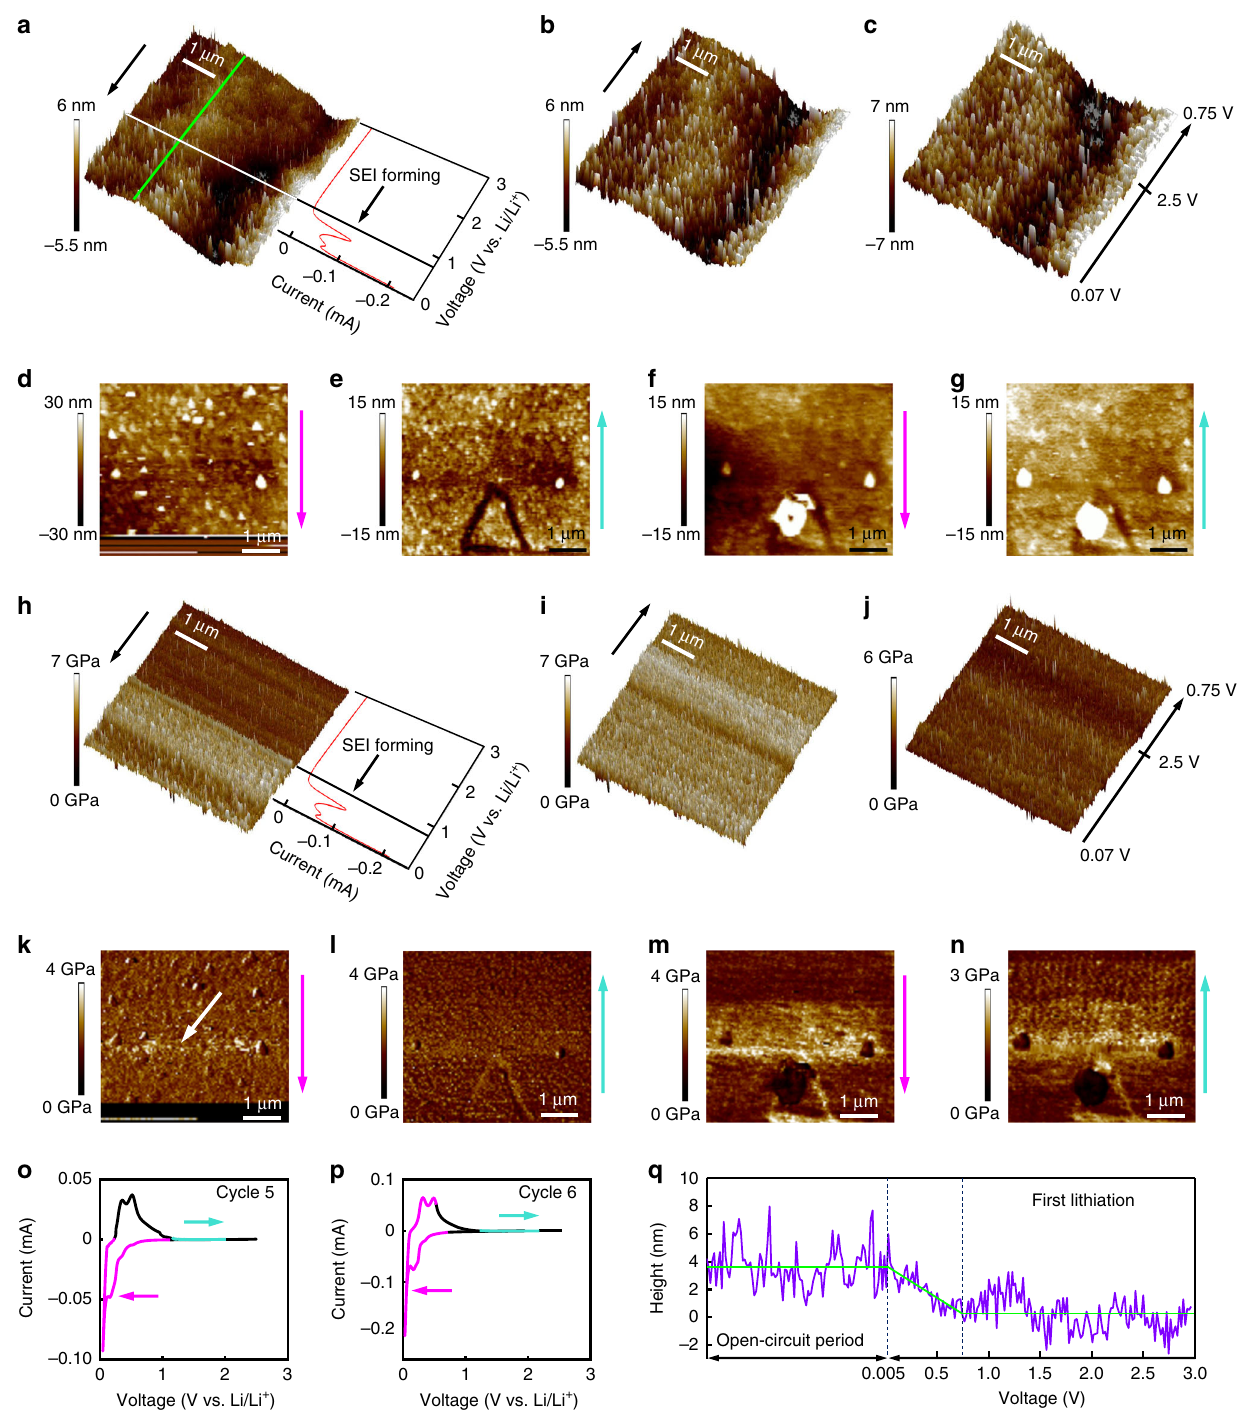
Fig. 5 Operando AFM measurements on the single-crystal Si electrode. Topographical map and current – voltage curve during the fi rst CV scan from E ocp to the cut-off potential of + 5 mV at a scan rate of 7 mV s − 1 ( a ), during the resting period ( b ), during the CV scan back to 2.5 V and down to 0.75 V ( c ). d and e are the topographic maps during the 5th CV cycle. f and g are the topographic maps during the 6th CV cycle. The current and voltage for d , e and for f , g are indicated respectively by the colored curve in o and p . The colored arrows to the right of each map indicate the direction of the topographic scans ( d – g ). Also shown are results of Young ’ s modulus measurements. The Young ’ s modulus maps in h – n are taken at the same time as the topographic maps in a – g , respectively. The missing data in d and k are caused by surface fl uctuations during the crack formation. q shows the height pro fi le of the surface during the fi rst lithiation and subsequent open-circuit